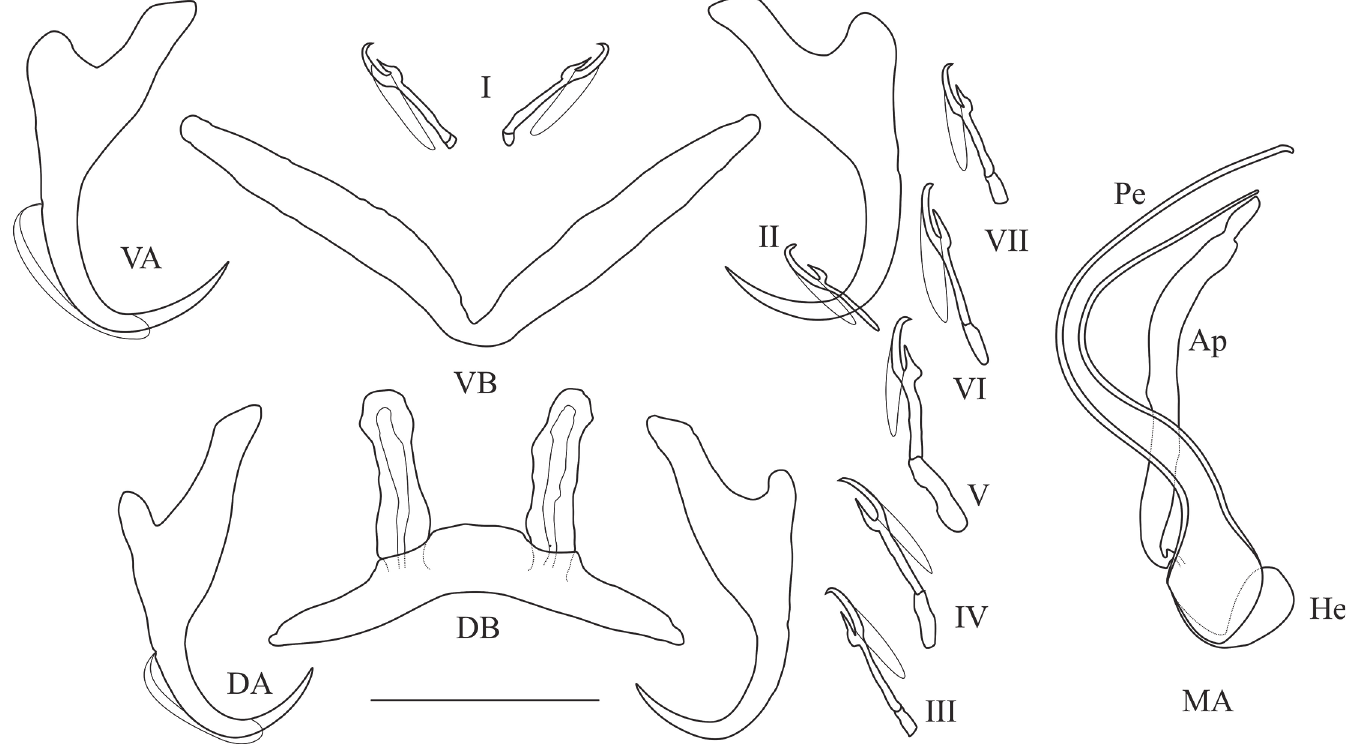
Fig 11. Haptoral and genital hard parts of Cichlidogyrus banyankimbonai sp. nov. (Ap) accessory piece (DB) dorsal transverse bar, (DA) dorsal anchor, (He) heel, (MA) male apparatus, (Pe) penis, (VB) = ventral transverse bar, (VA) ventral anchor, (I) to (VII) uncinuli, scale bar = 20 μ